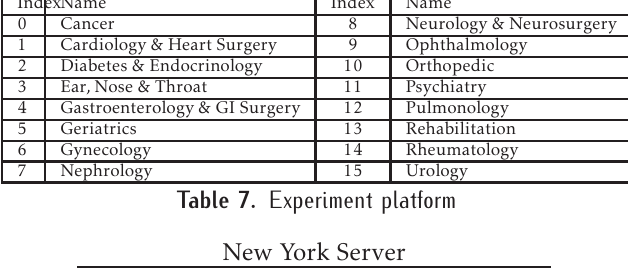
Table 8. Effectiveness of P 3